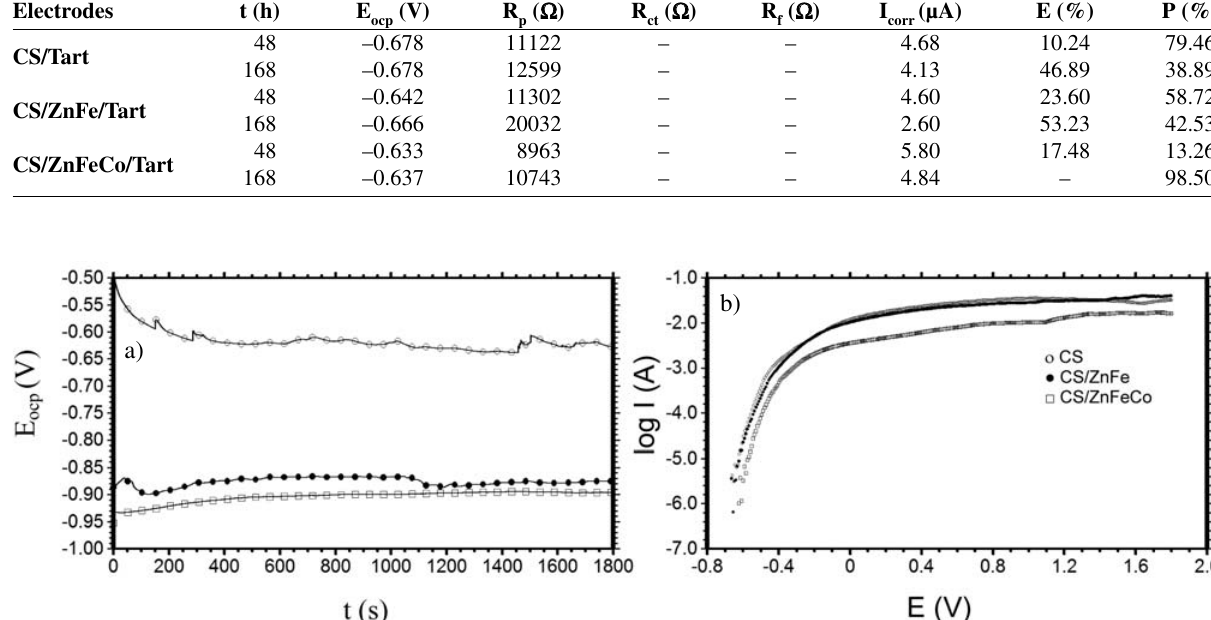
Fig. 9. The E -t diagrams immediately after of immersion time (a) and the anodic polarization curves after 168 h of exposure time (b) obtained for ocp electrodes, in 3.5% NaCl solution.